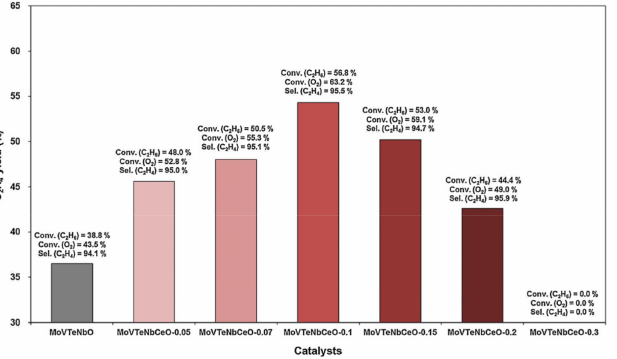
Figure 15. Catalytic performance of Ce-doped MoVTeNb(Ce)O catalyst with various Ce contents. Adapted from ref. [115], Copyright (2018), with permission from